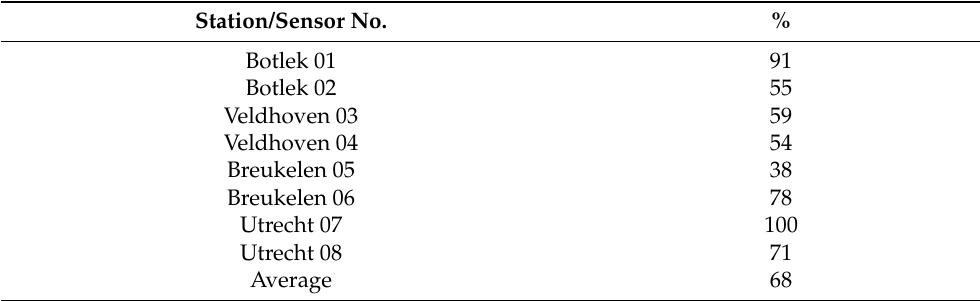
Table 1. Data coverage at the measurement sites for each sensor system. Number of hours with valid hourly averaged sensor output as a percentage of the total number of hours in the measurement period (one